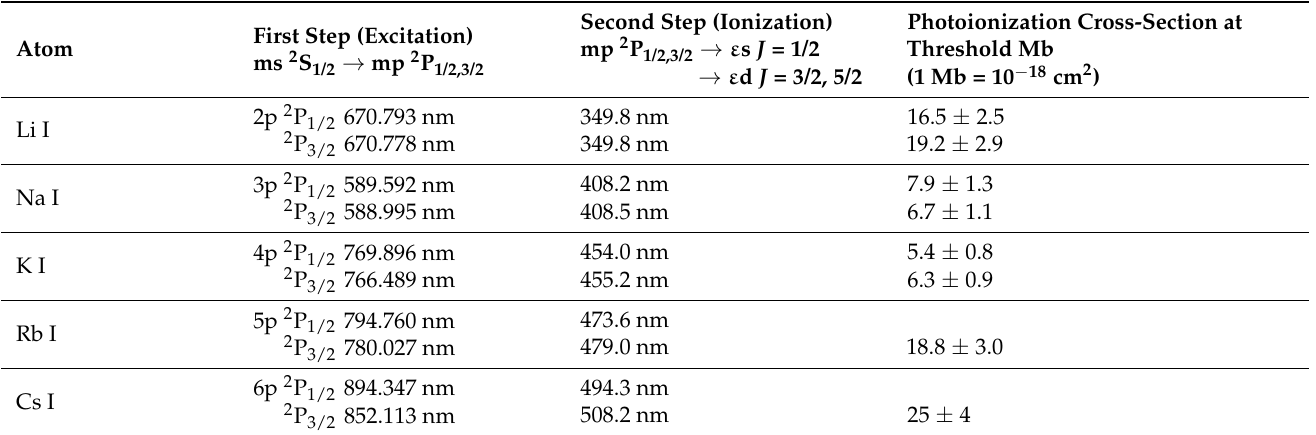
Table 3. Experimentally measured values of the photoionization cross-section for the resonance transitions of alkali